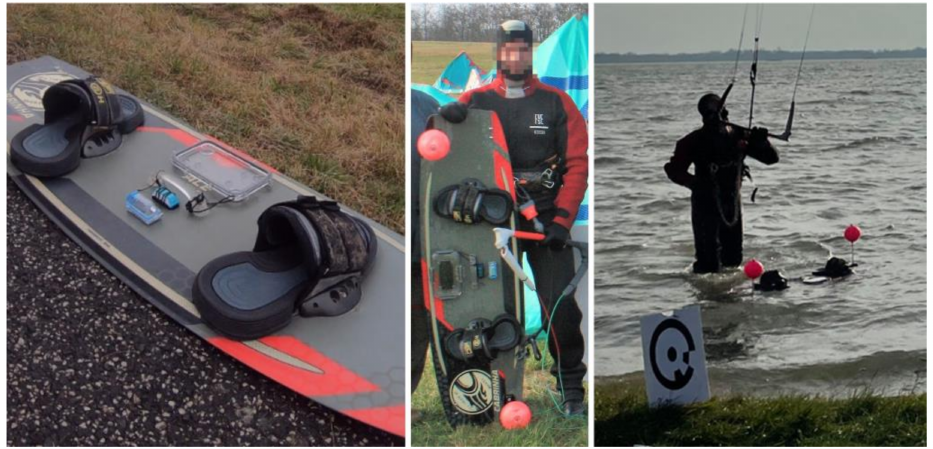
Figure 1. 2015 Cabrina Ace twintip, including WOO2 and WOO3 sensors, iPhone SE smartphone, and polystyrene spherical targets for